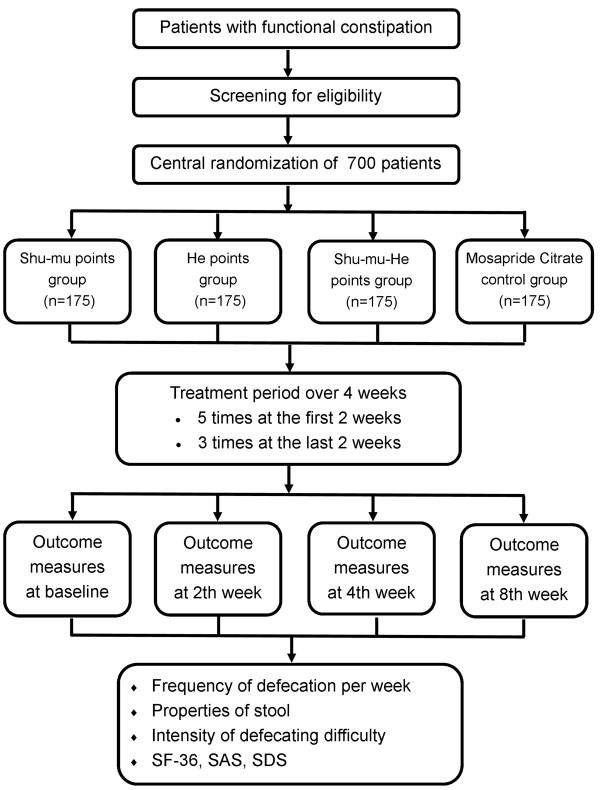
Trial flow chart.